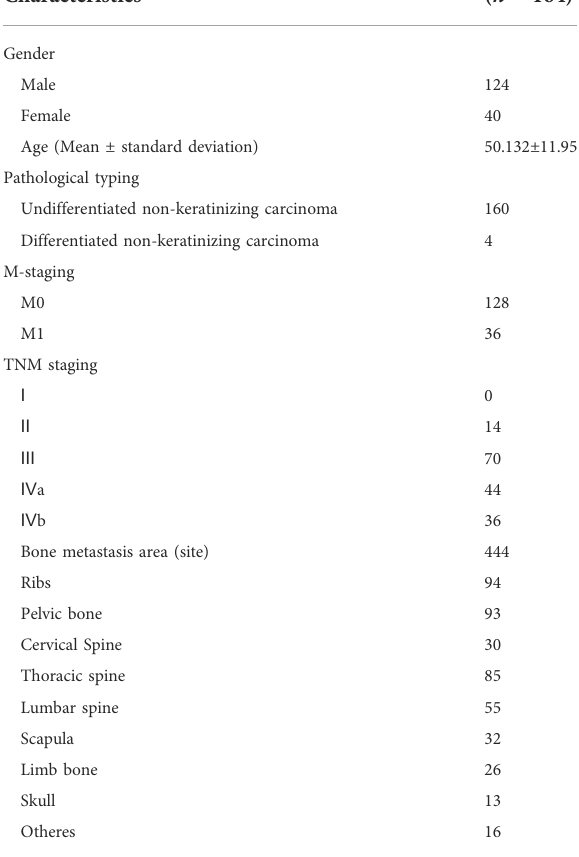
TABLE 1 Basic data characteristics of 164 cases of nasopharyngeal carcinoma.